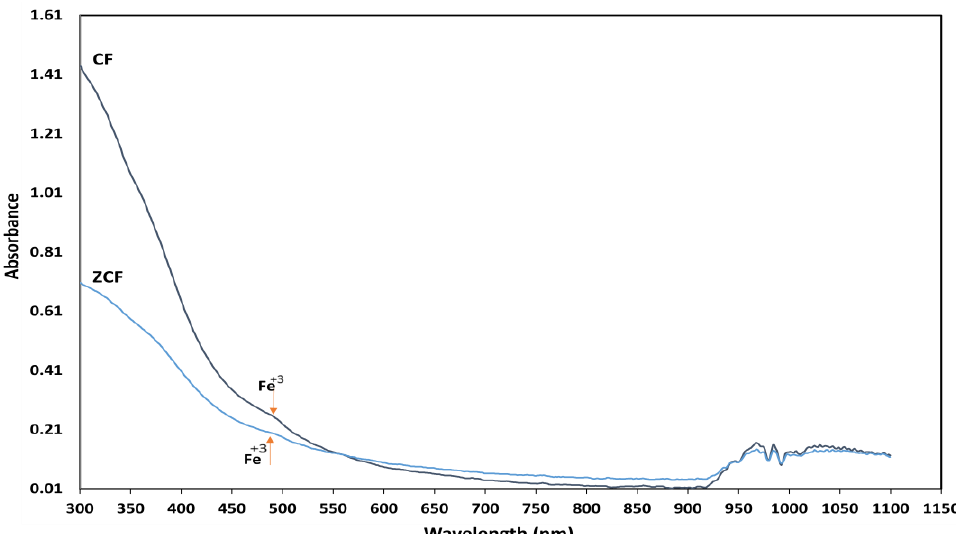
Nanomaterials 2019 , 9 , x FOR PEER REVIEW Figure 4. Optical absorbance spectra of CF-MNPs and ZCF-MNPs. Figure 4. Optical absorbance spectra of CF-MNPs and ZCF-MNPs.